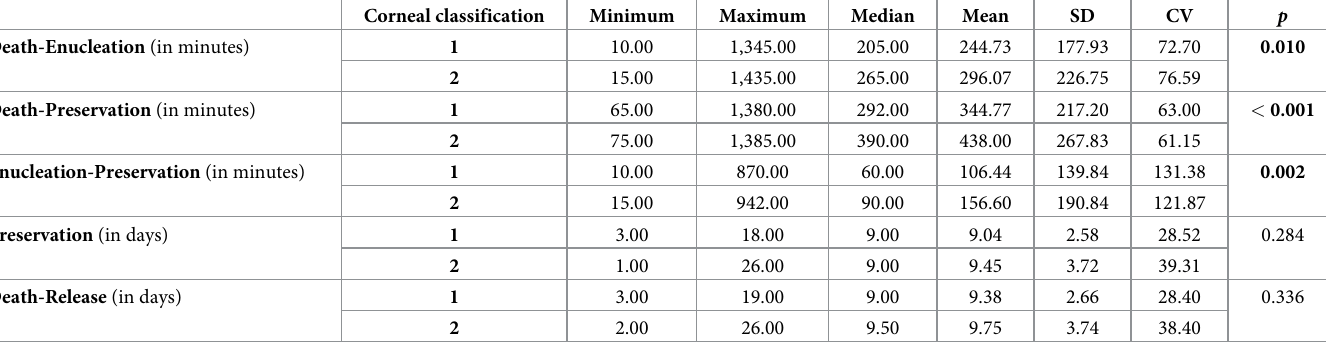
Table 4. Corneal quality versus chronological variables. Brazil, 2020 (n =